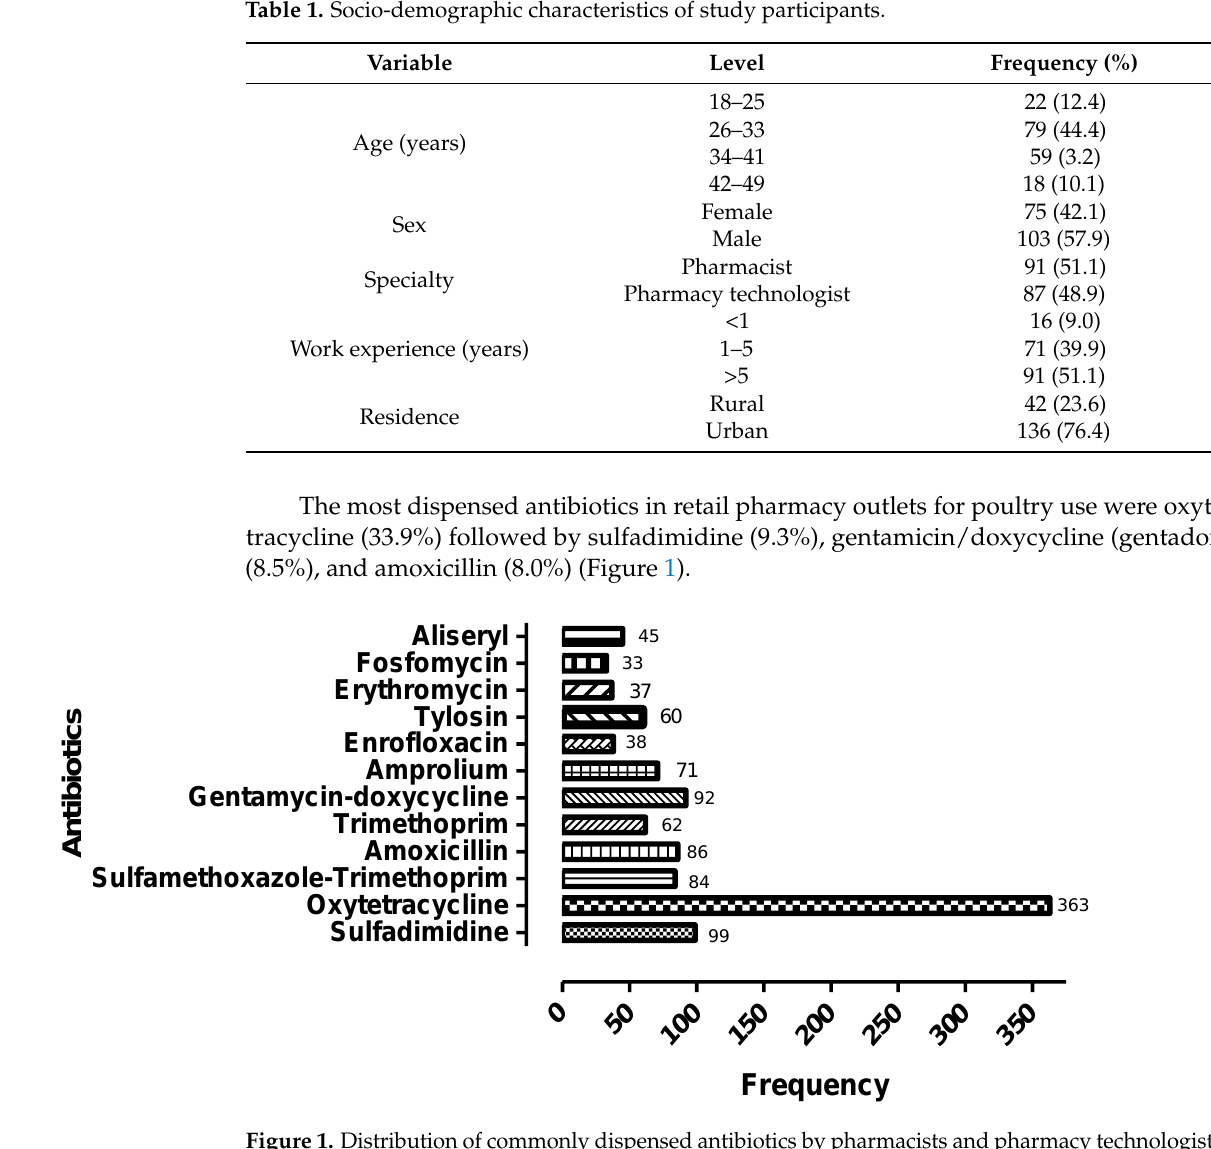
Table 1. Socio-demographic characteristics of study participants.